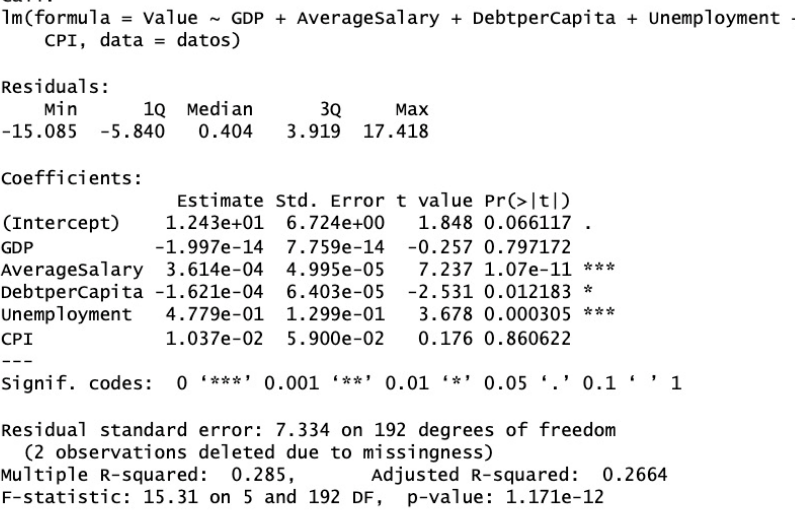
Figure 7. Regression Value.